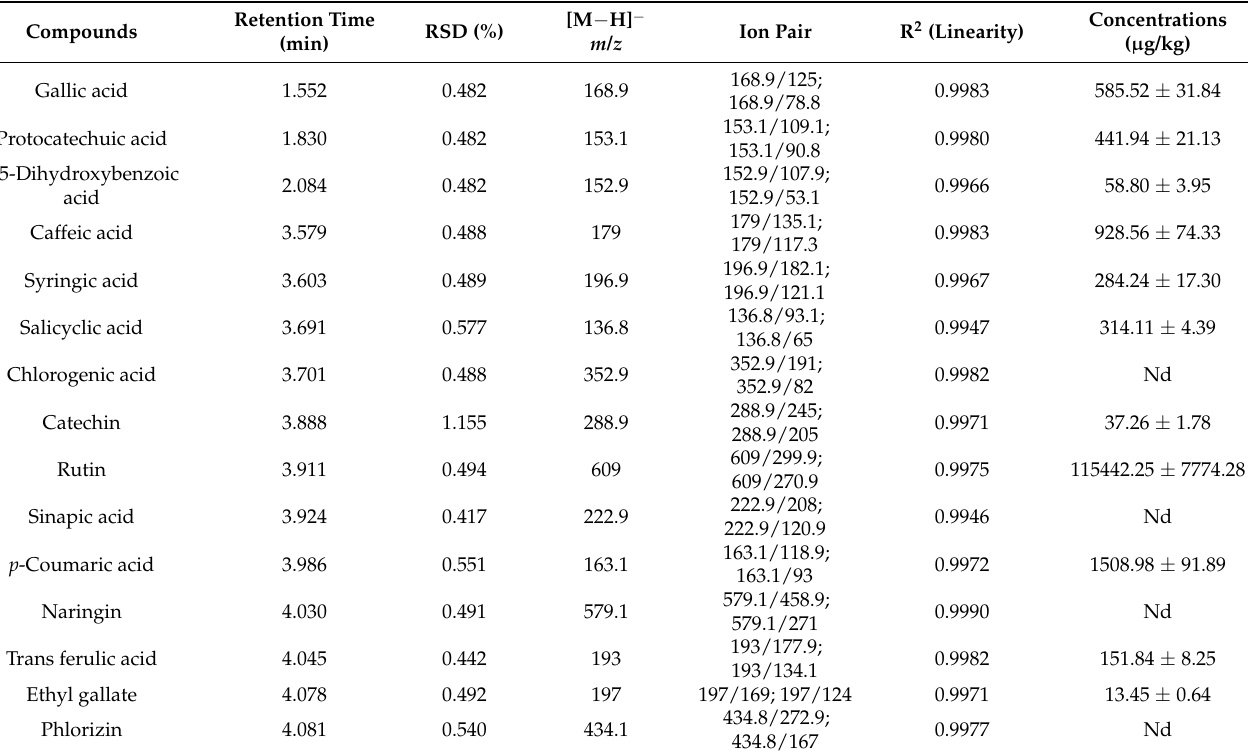
Table 2. Concentrations of polyphenolic compounds in pollen extract ( µ